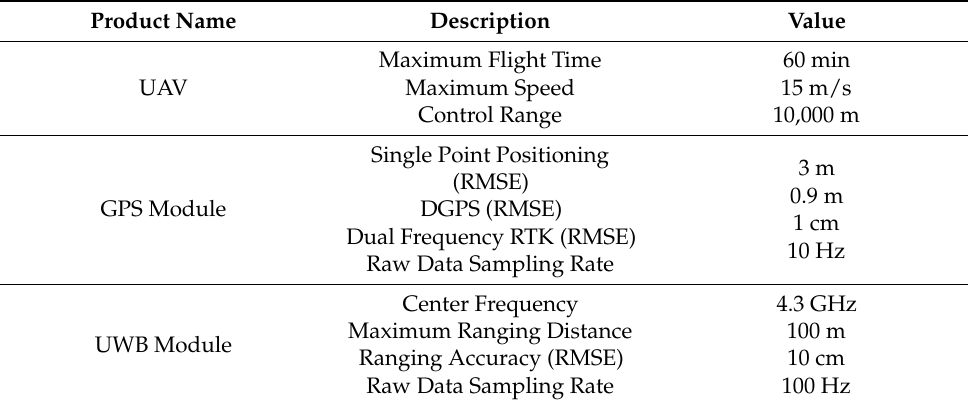
Table 1. Descriptions for the products in the experiments.